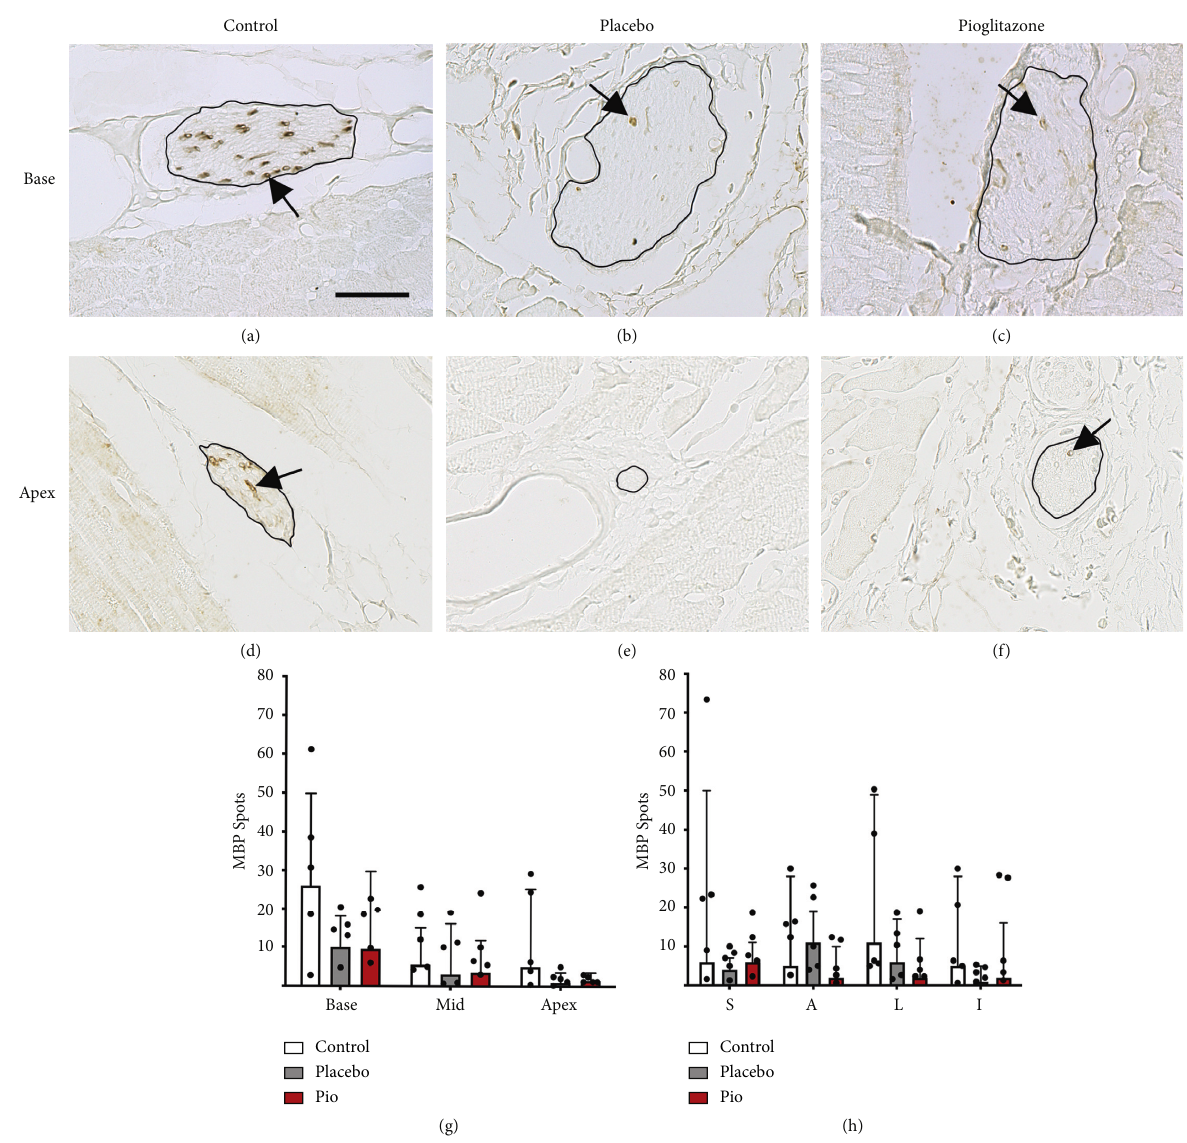
Figure 3: Cardiac MBP-immunoreactive (-ir) spot number is significantly decreased following systemic 6-OHDA. Photomicrographs (a–f) of MBP-ir spots (black arrows) in myocardial nerve bundles (outlined in black) in the cardiac base level (a–c) or apex level (d–f) in normal control (a, d), 6-OHDA+placebo-treated (b, e), or 6-OHDA+pioglitazone-treated (c, f) animals. Scale � 25 μ m. Bar graphs (g, h) of the median number of MBP-ir spots counted in each level (g) or region (h) in each treatment group. Error bars show the interquartile range. Black points represent individual animal means; see manuscript results text for statistics. MBP, myelin basic protein; pio, pioglitazone; Mid, middle cardiac level; S, septal; A, anterior; L, lateral; I,